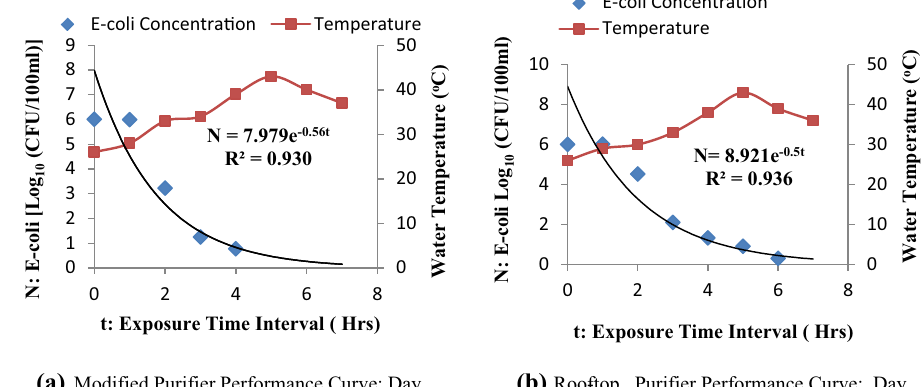
Fig. 10 a and b Day 3: Side- By-Side Performance Curves of the Improved SODIS and the Conventional SODIS